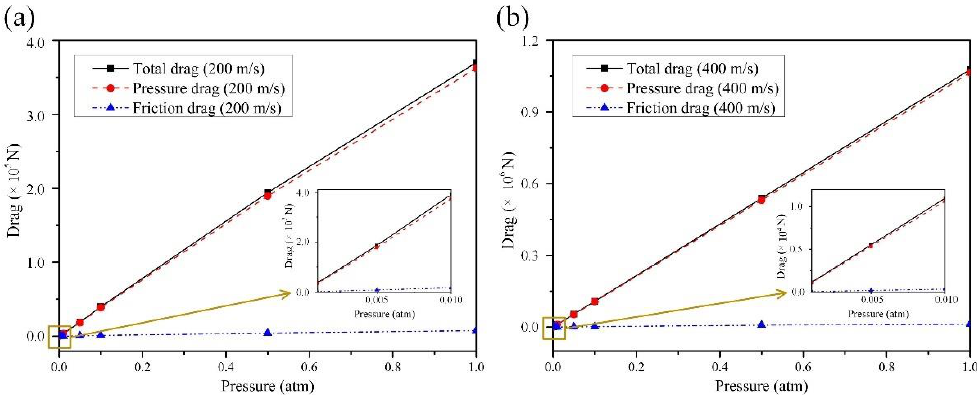
Figure 14. Relationship between the drag and ambient pressure in the tube: ( a ) 200 m/s, ( b ) 400 m/s.